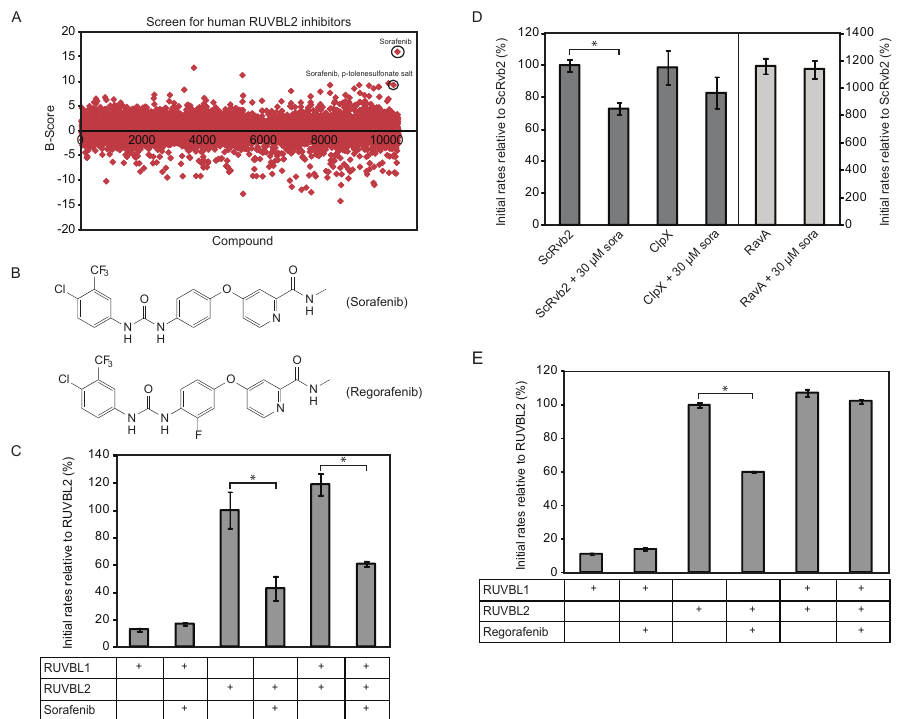
Figure 1. Identification of sorafenib as an inhibitor of the ATPase activity of RUVBL2. ( A ) High-Throughput Screen (HTS) based on the ATPlite assay was used to screen the DIVERSet ™ collection from ChemBridge Corp. (10,000 drug-like molecules) and Kinase Inhibitor Library (200 compounds) for inhibitors of RUVBL2 ATPase activity. B-scores were calculated for all the compounds as described in the Methods section. 49 compounds were found to be above three standard deviations and were retested. Sorafenib and sorafenib-p-toluensulfonate salt were validated as hits (circled). ( B ) Shown are the structures of sorafenib (top) and its analog regorafenib (bottom). ( C ) Initial ATPase rates of RUVBL1, RUVBL2 and RUVBL1 / RUVBL2 complex were measured at 10 µ M protomer concentration in the presence and absence of 20 µ M sorafenib. Initial rates of proteins are reported relative to that of RUVBL2 WT as percentage. ( D ) Initial ATP hydrolysis rates of yeast Rvb2 (ScRvb2; 10 µ M protomer concentration), E. coli ClpX (1 µ M protomer concentration) and E. coli RavA (1 µ M protomer concentration) were measured in the presence and absence of sorafenib at 30 µ M concentration. Initial rates are reported relative to that of ScRvb2 as percentage. ( E ) Initial ATP hydrolysis rates of 10 µ M protomer concentration of RUVBL1, RUVBL2, and RUVBL1 / RUVBL2 complex were measured in the presence and absence of 15 µ M regorafenib. A (*) in panels ( C – E ) indicates that the di ff erence between the two compared ATPase activities is significant with p -value <